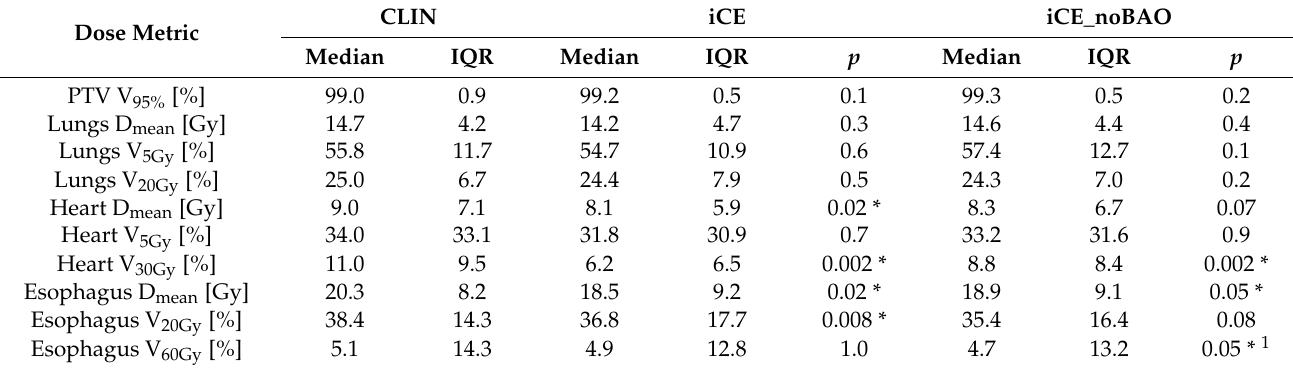
Table 5. Dose-volume metrics for CLIN compared with iCE and iCE_noBAO plans. Median value and interquartile range (IQR) is given, along with p -values for difference with regard to CLIN. Significant differences from CLIN are marked with *. Dose Metric